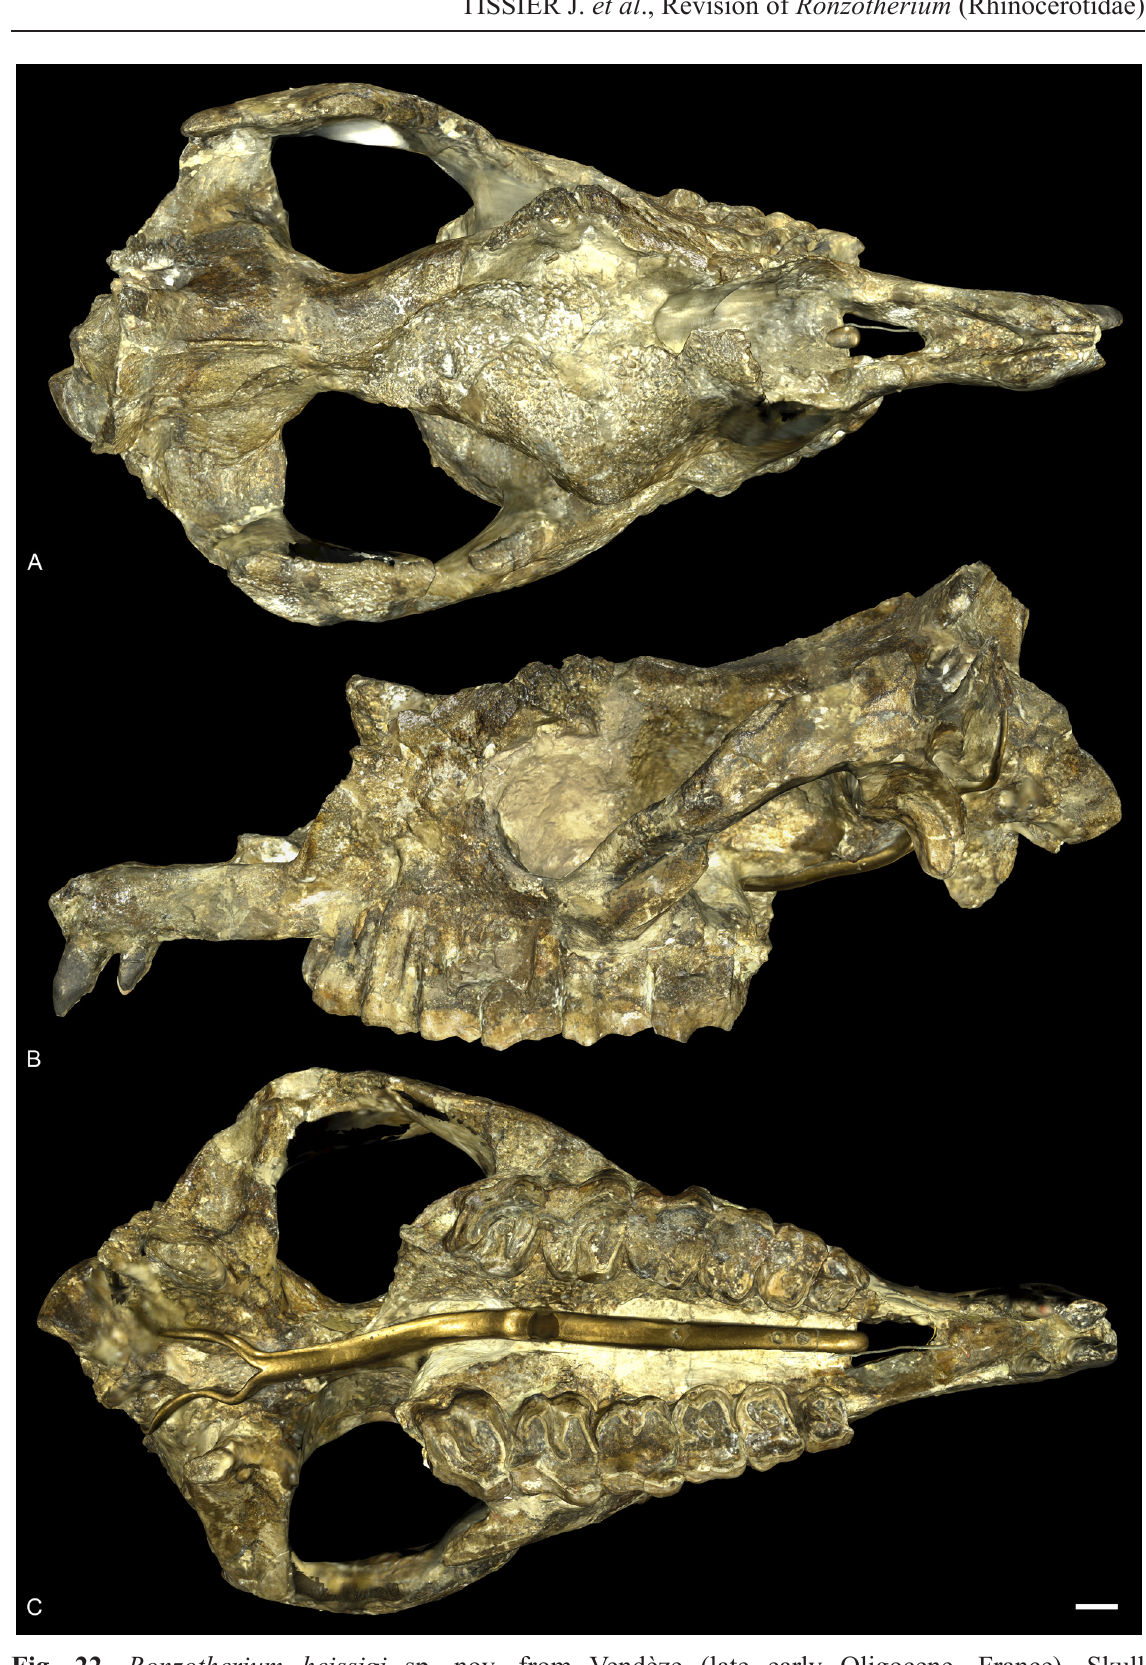
Fig. 22. Ronzotherium heissigi sp. nov. from Vendèze (late early Oligocene, France). Skull MNHN.F.LIM181. A . Dorsal view. B . Left lateral view. C . Ventral view. Scale bar: 2